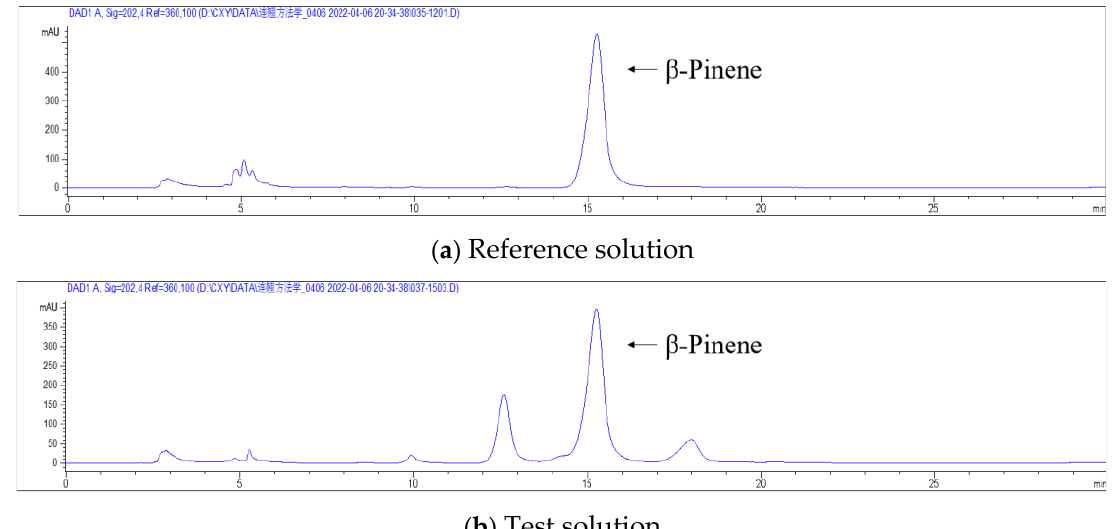
Figure 2. HPLC c hromatograms of β -pinene. Figure 2. HPLC chromatograms of β